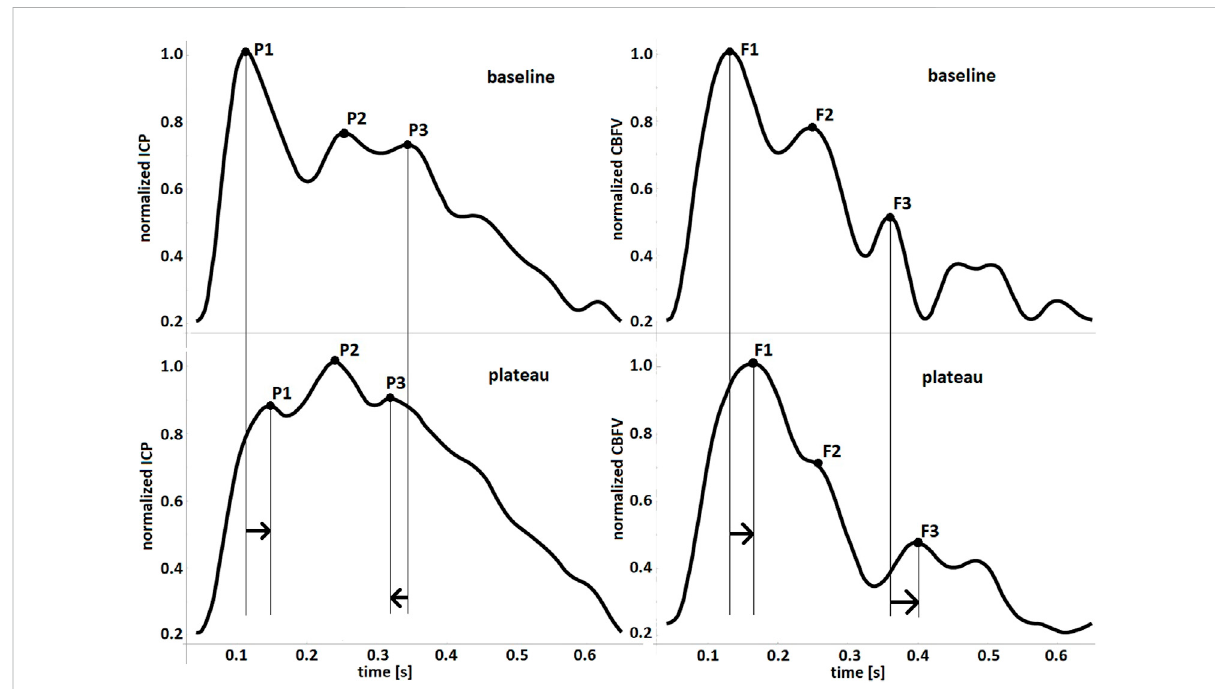
FIGURE 7 Observed changes in peak appearance times during episodes of intracranial pressure (ICP) plateau waves presented in handpicked pulse waveforms of ICP (left-hand charts) and cerebral blood fl ow velocity (CBFV, right-hand charts). The arrows indicate direction of changes in peak appearance times.